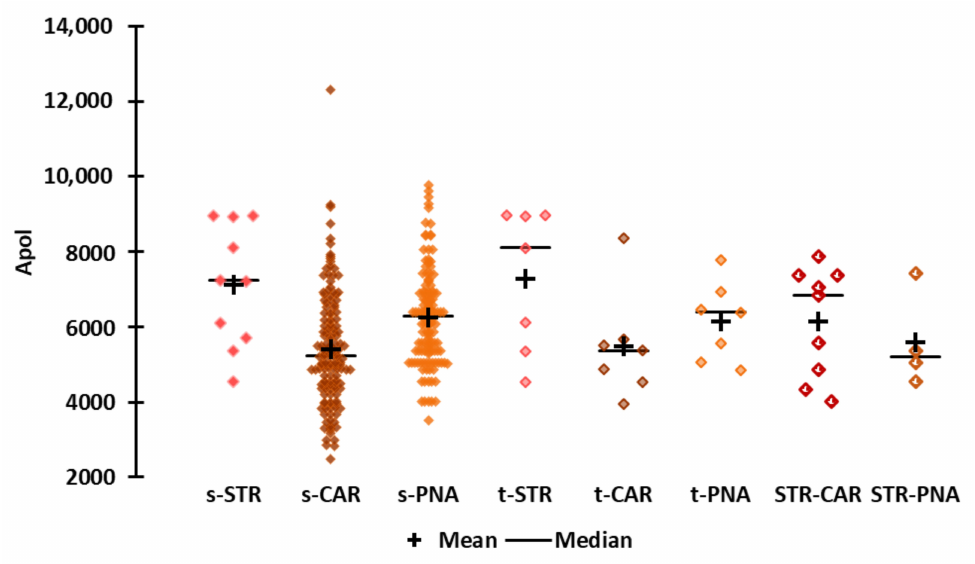
Figure 4. Scattergrams of the Apol values by odor